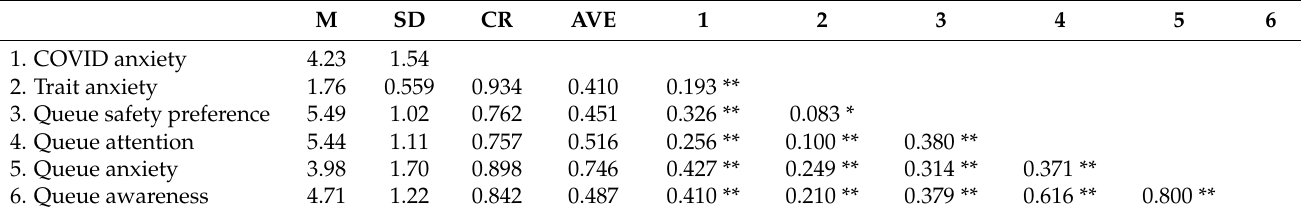
Table 3. Descriptive statistics, composite reliability, Kendall’s tau correlation